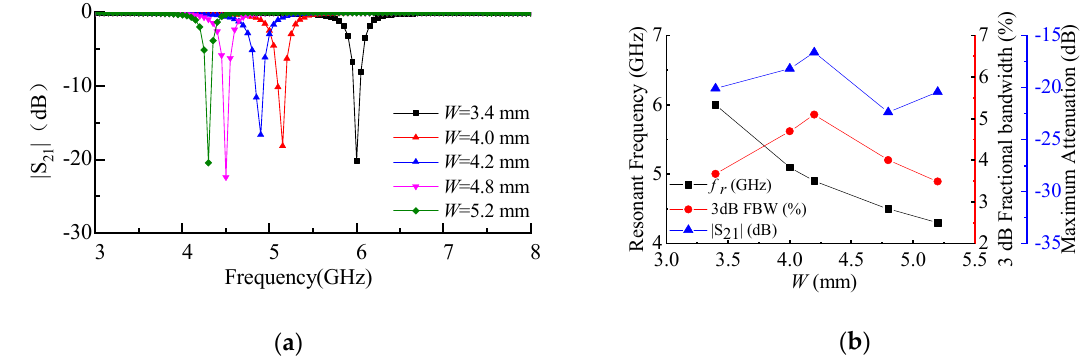
Figure 4. ( a ) Simulation results with different W by using HFSS. ( b ) Resonant frequency, maximum attenuation, and 3 dB Fractional Bandwidth with different W.